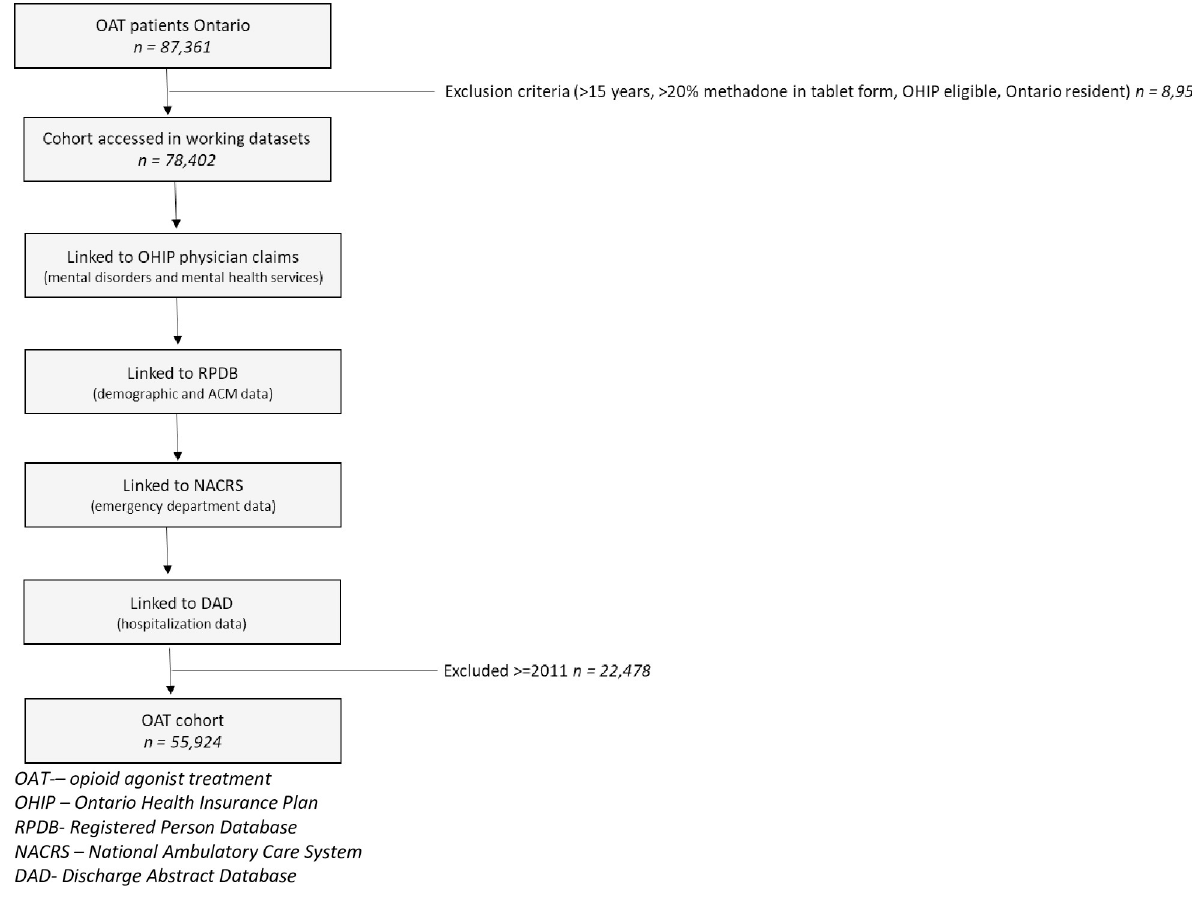
Fig 1. Flow chart outlining data build including